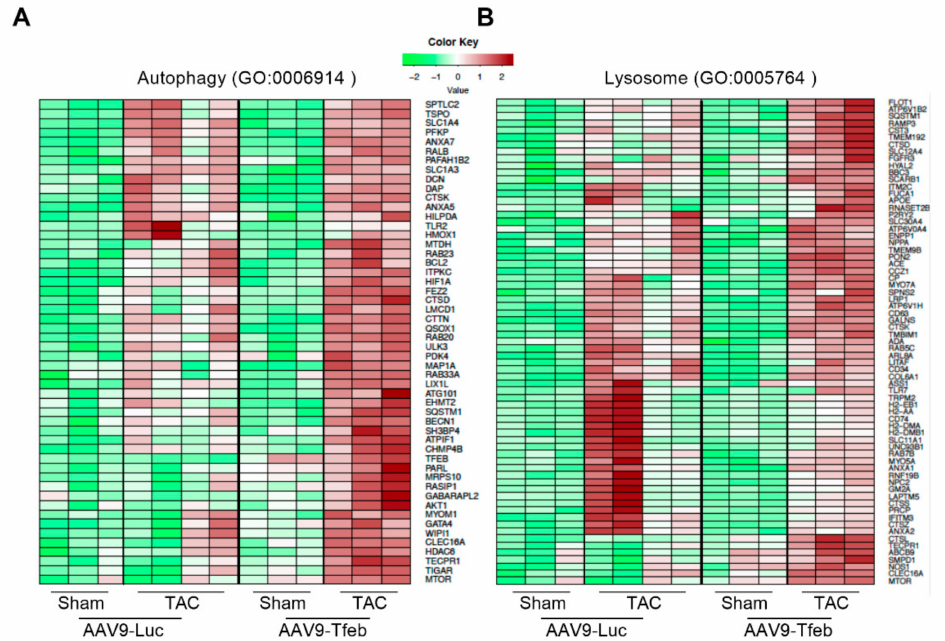
Figure 4. RNA sequencing reveals that TFEB increases the expression of ALP genes during TAC. Heat maps showing the expression of genes that are enriched GO-terms ( A ) autophagy (GO:0006014) and ( B ) lysosome